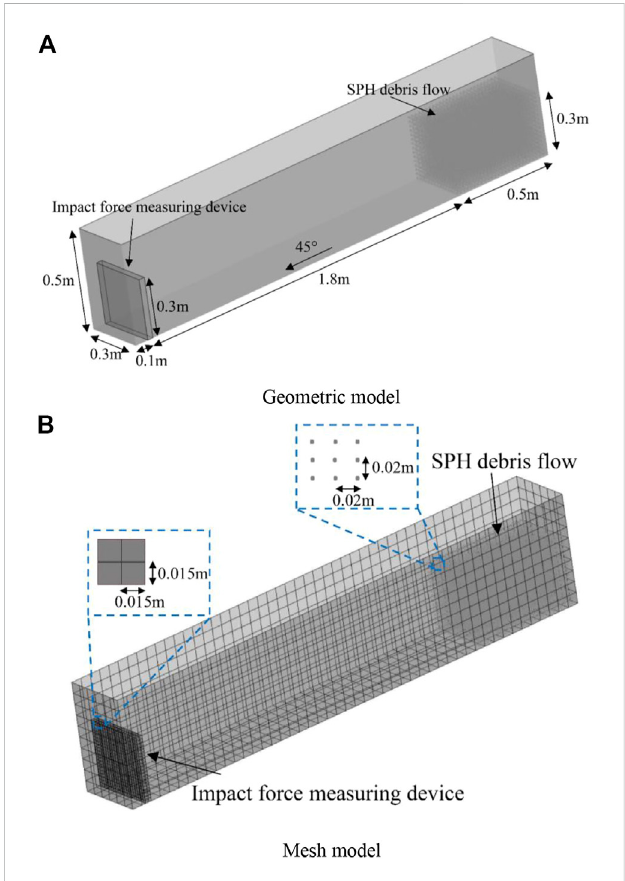
FIGURE 9 The coupled SPH-FEM numerical debris fl ow impact model (A) Geometric model (B) Mesh model.